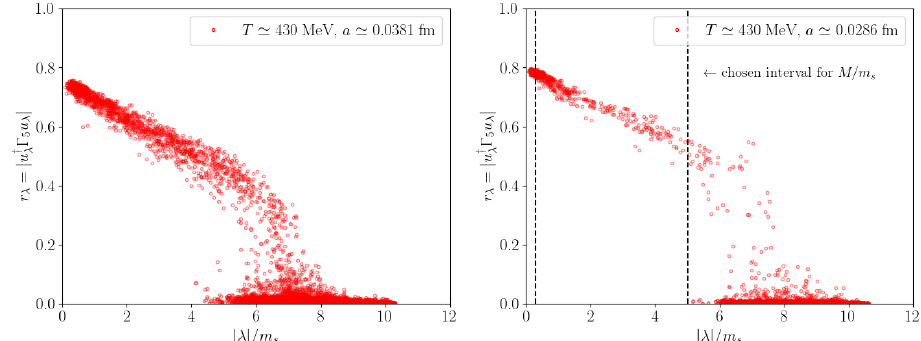
Figure 1. Scatter plot of the (absolute value of the) chirality r λ vs | λ | / m s for the first 200 eigenvalues of configurations generated at T (cid:10) 430 MeV. (Left) for a (cid:10) 0 . 0381 fm, (Right) for a (cid:10) 0 . 0286 fm. The two vertical dashed lines at | λ | / m s = 0 . 03 and 5 delimit the M -range used to check for